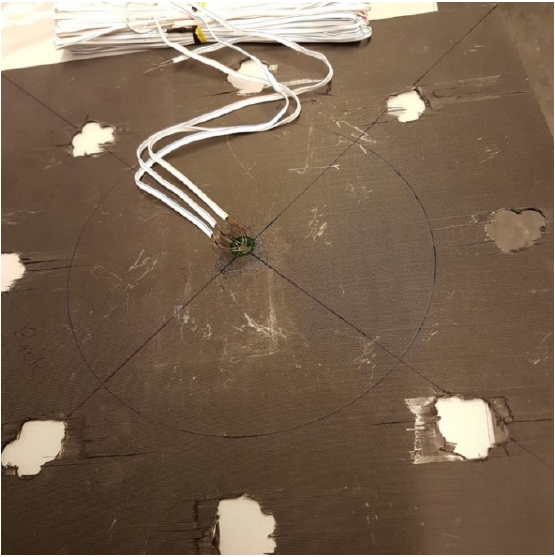
Figure 4. The rosette strain gauge attached to the back of the CFRP sample.